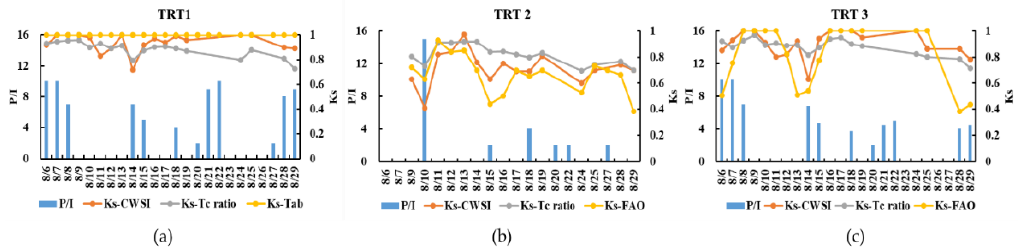
Figure 6. Comparison of the Kcb values calculated by using two methods in three different treatments: TRT 1 ( a ), TRT 2 ( b ) and TRT 3 ( c ). The Kcb-NDVI values were retrieved from regression model (Equations (10) and (11)) of Kcb vs. NDVI, and Kcb-Tab were calculated by the modified FAO-56 method (Equations (4) and (5)).